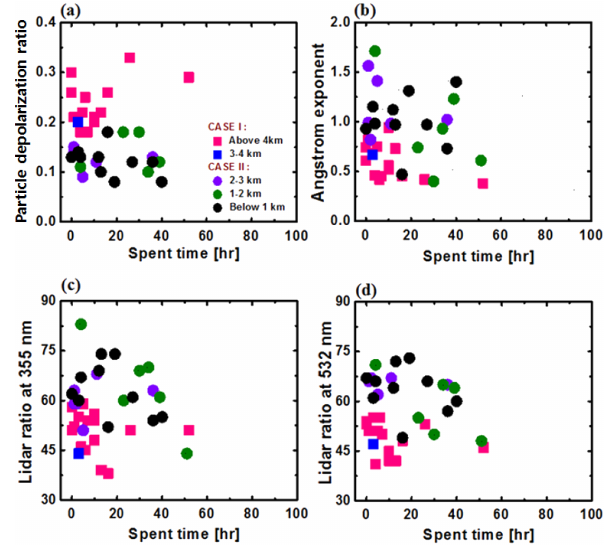
Figure 9. Scatterplot of optical dust properties versus the time the Asian dust layers traveled over polluted regions in China. Shown are (a) the particle depolarization ratio, (b) the backscatter-related Ångström exponent (355/532nm wavelength pair), (c) the lidar ra- tio at 355nm, and (d) the lidar ratio at 532nm with respect to their altitude above ground when they passed over industrial regions of China. The corresponding altitude of Asian dust layers is distin- guished by color (black: below 0km; green: 1–2km; purple: 2– 3km; blue: 3–4km; red: above